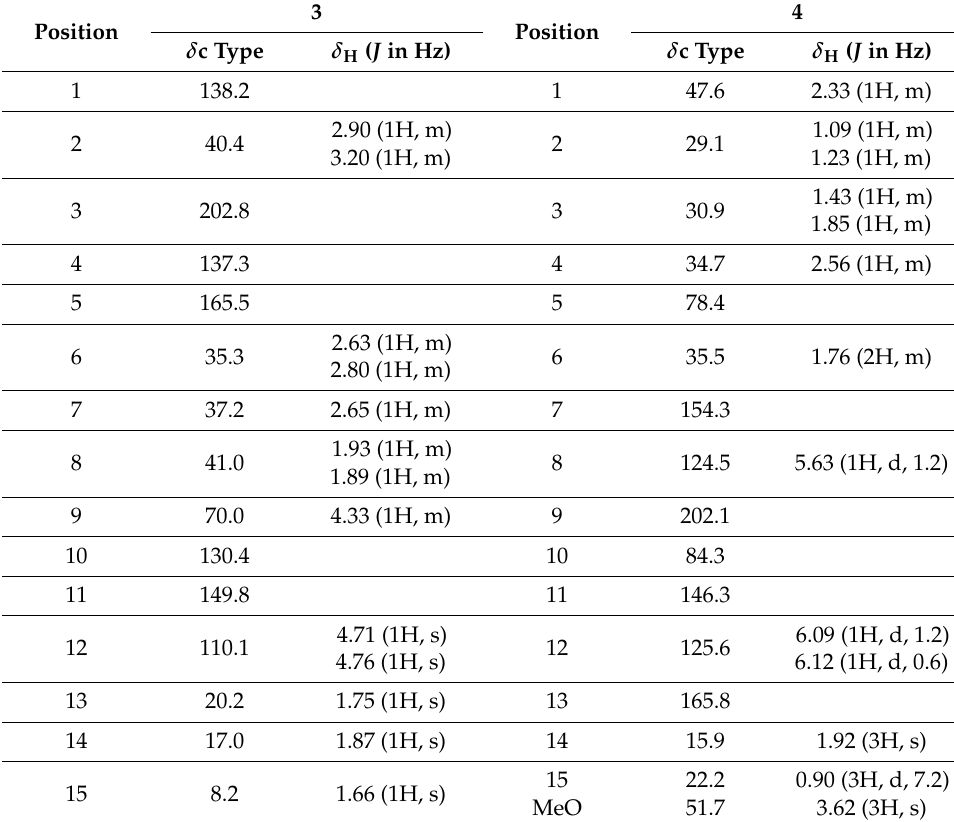
Table 2. 1 H (600 MHz) and 13 C-NMR (150 MHz) spectral data for compounds 3 and 4 (in DMSO- d 6 ). 3 Position